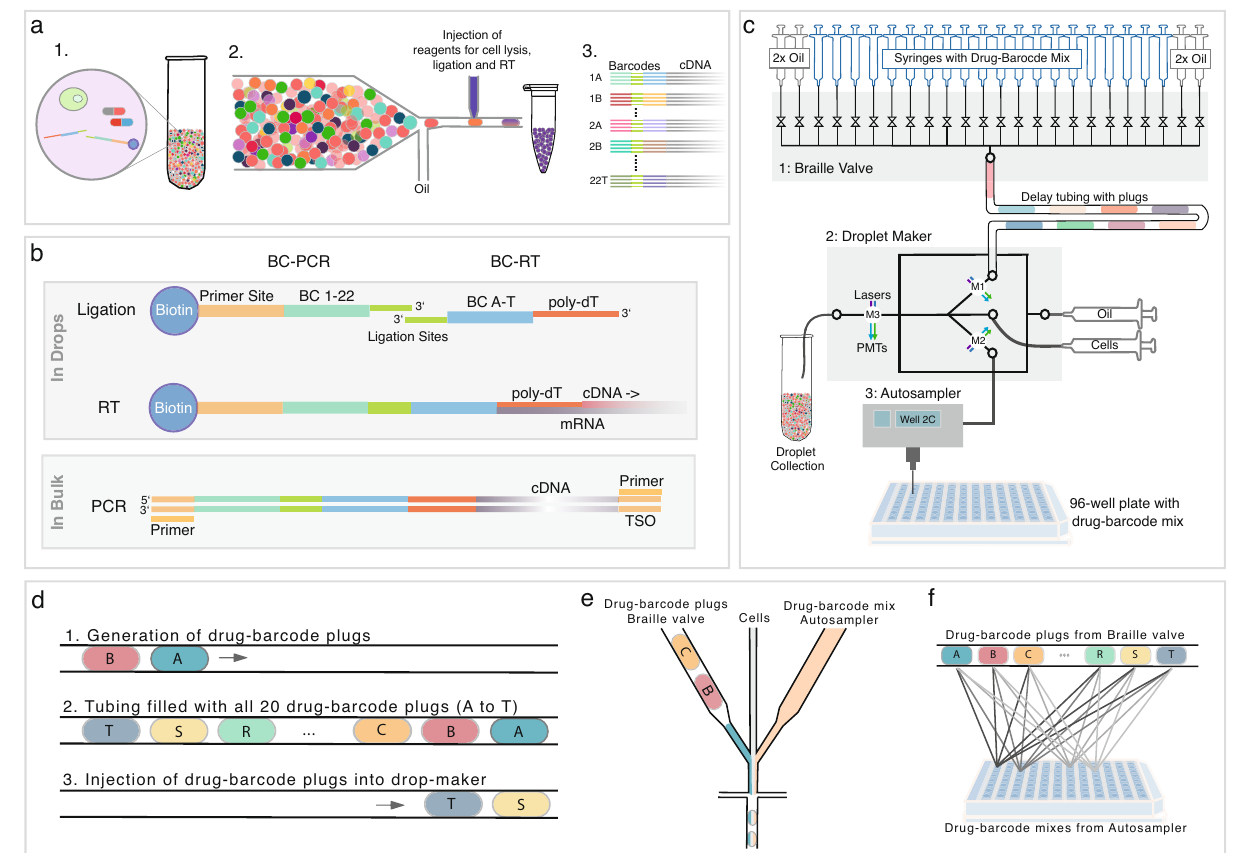
Fig. 1 | Combi-Seq work fl ow and micro fl uidic pipeline. a Overview Combi-Seq work fl ow:(1)Cellswereencapsulatedwithdrugcombinationsandpairsofbarcode fragments encoding drugs. (2) After off-chip incubation, droplets were reinjected into a chip for picoinjection to add reagents for barcode ligation and reverse transcription (RT), enabling barcoding of the transcriptome according to the drug treatment. (3) Upon droplet breakage, pooled libraries for sequencing were gen- eratedin which cellsfrom the same treatment group share the same barcode.This facilitated demultiplexing of drug treatments and gene expression-basedreadouts for pools of 250 cells. b Barcoding strategy applied to encode and decode drug combinationsforlowinputcellpools.PairsofbarcodedPCRprimers(BC-PCR)and barcoded poly-dT primers (BC-RT) were joined in a ligation reaction to form